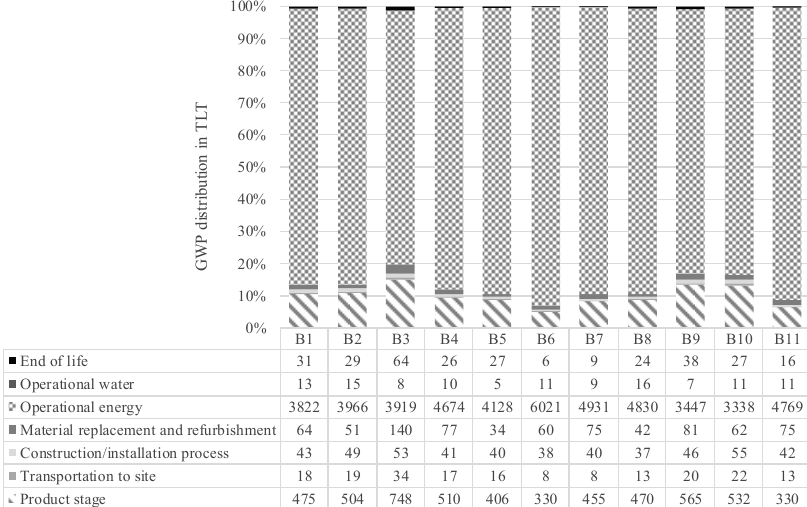
Figure 3. Distribution of the Global Warming Potential (GWP) index over a building’s life cycle. The values in the table are shown in kgCO 2 eq/m 2 and were calculated for TLT = 60 years.